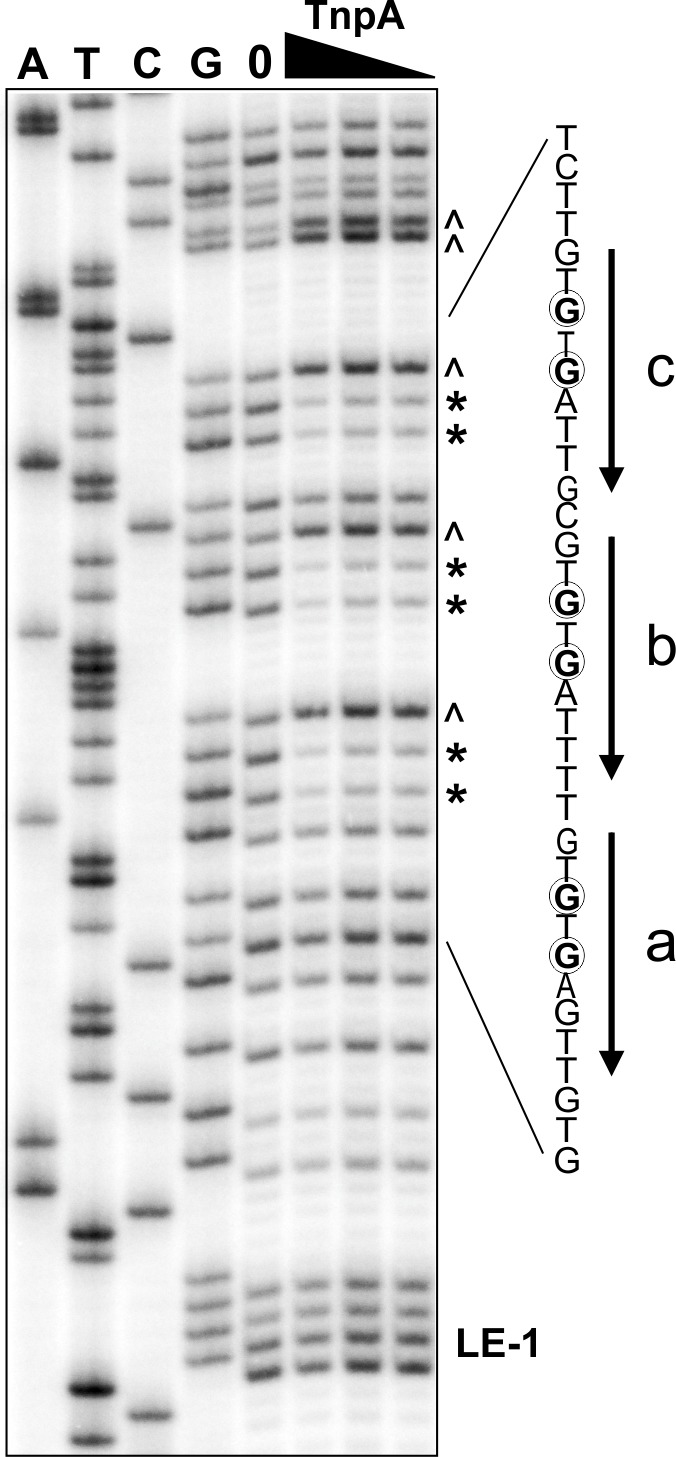
Dimethyl sulfate (DMS) protection assay on the IS1535 LE to identify major groove (guanine N7) contacts.An LE probe end labeled on the G-rich bottom strand was incubated with 0, 32, 64, and 128 nM TnpAIS1535 for 1 hr under PEC assembly conditions and then reacted with DMS. The first four lanes are dideoxy sequencing reactions and the next four lanes are DMS reactions without and with TnpA. Guanines within motifs a-c that are protected from DMS modification, and therefore cleavage by piperidine, are highlighted with asterisks and circled. Carets (^) indicate guanines exhibiting moderately increased reactivity with DMS. LE-1 is the first base of the left end. Dideoxy-terminated or piperidine-cleaved DNA fragments migrate slightly differently.